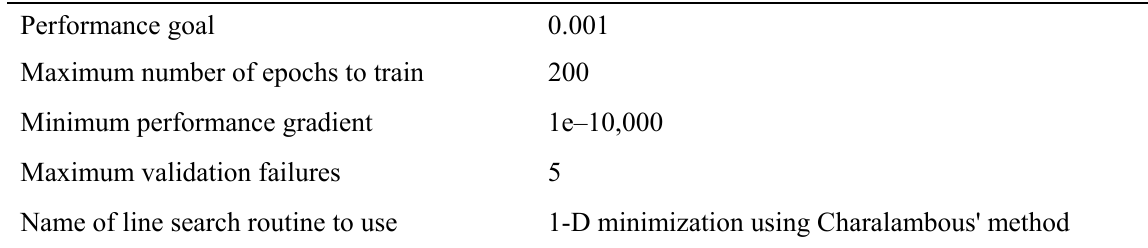
Table 2 . The training parameters for the BFGS training